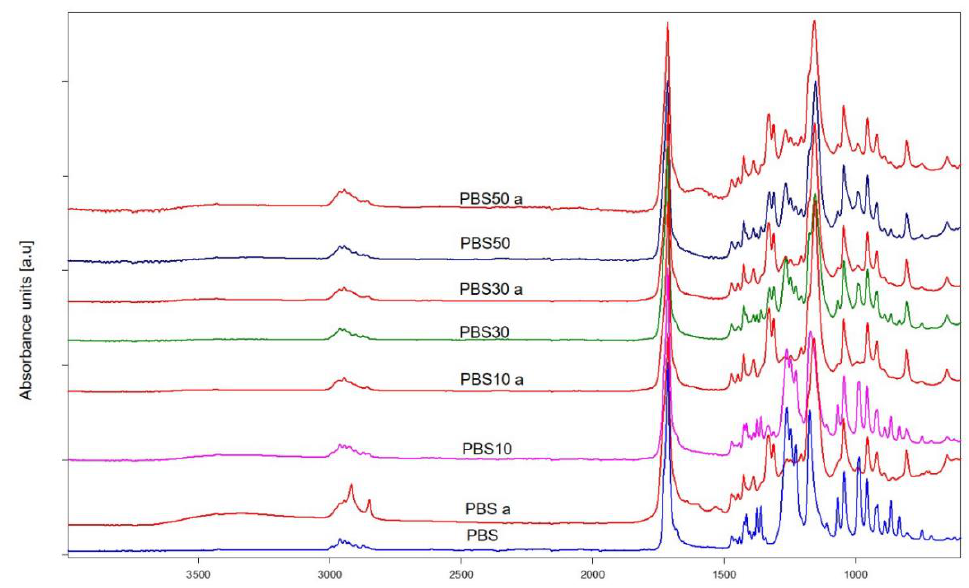
Figure 14. Spectra of samples made of poly(butylene succinate) and its composition with bran, before and after the flammability test (a).